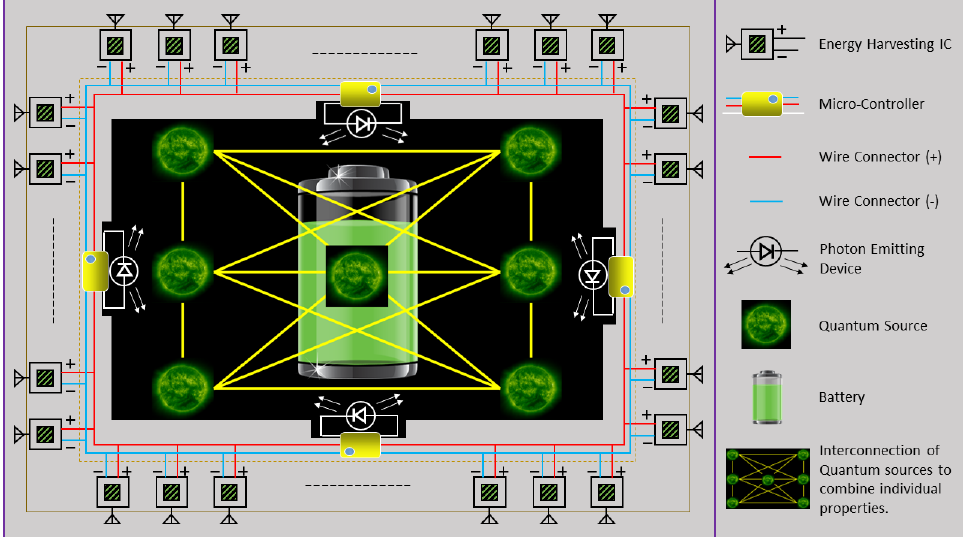
Figure 3. Prototype of the proposed novel and futuristic RF-EH ICs-assisted QB system